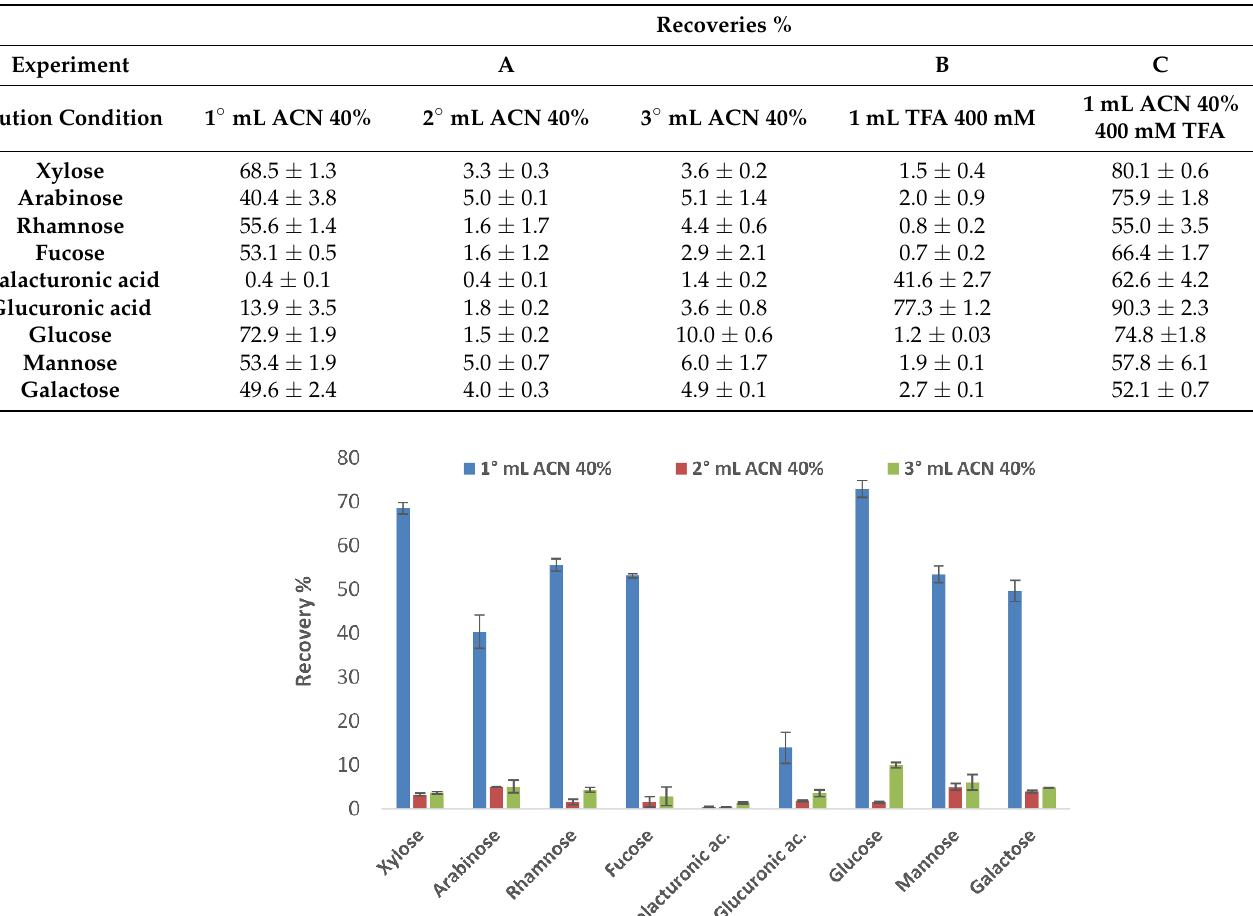
Table 3. Results obtained for a clean-up test using a Macherey-Nagel™ Chromabond™ NH2 Polypropylene SPE column applied to a standard solution of 7 monosaccharides and 2 uronic acids (each at 10 ppm). For the percentage recoveries, the relative confidence interval is reported. The measurements were conducted in triplicate. Experiment A and B refers to the optimization of the volume and the pH of elution respectively while experiment C represent the best results. Recoveries %